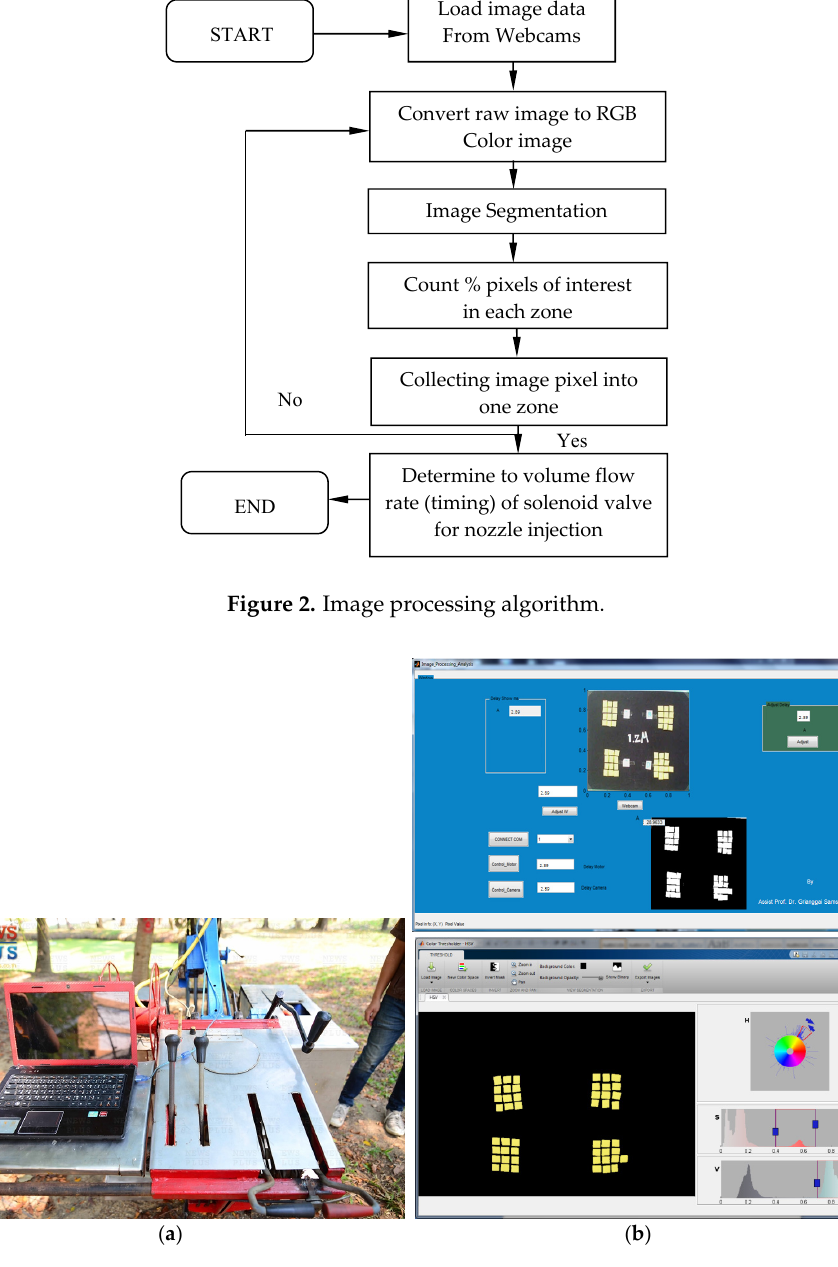
Figure 3. Image processing software; ( a ) Operating system; ( b ) Yellow thresholding.